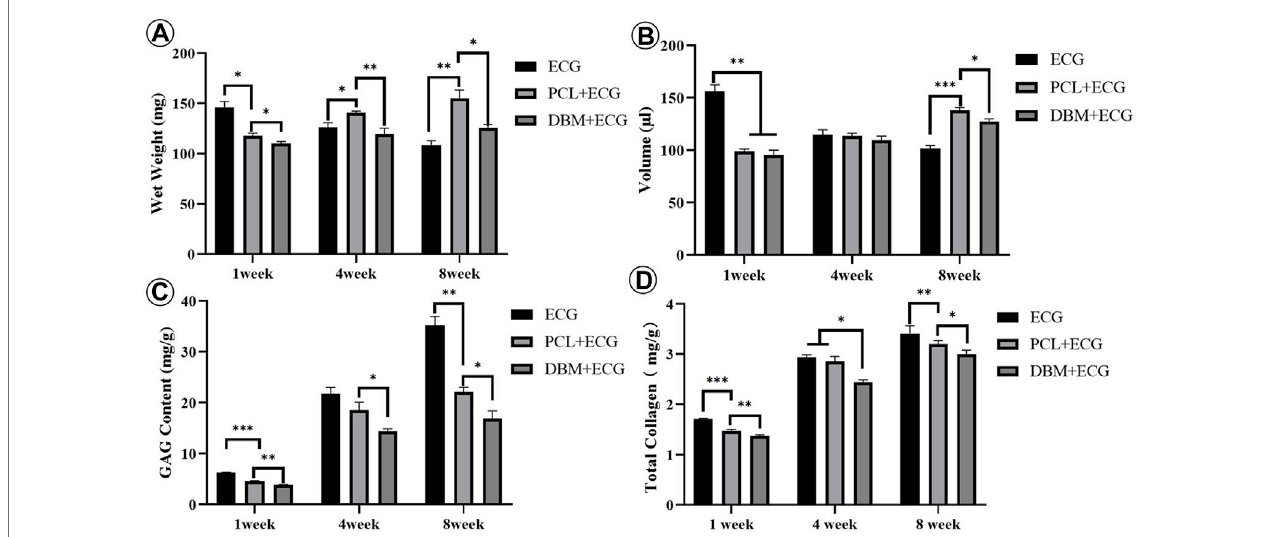
FIGURE9| Quantitative evaluationsofthe regenerated cartilagein ECG, PCL-ECG, and DBM-ECG groups after 1, 4,and 8 weeksofsubcutaneous implantation: (A) wet weight, (B) volume, (C) total glycosaminoglycan (GAG) content, and (D) total collagen content. Statistical signi fi cance: p p < 0.05, pp p < 0.01, ppp p < 0.001.